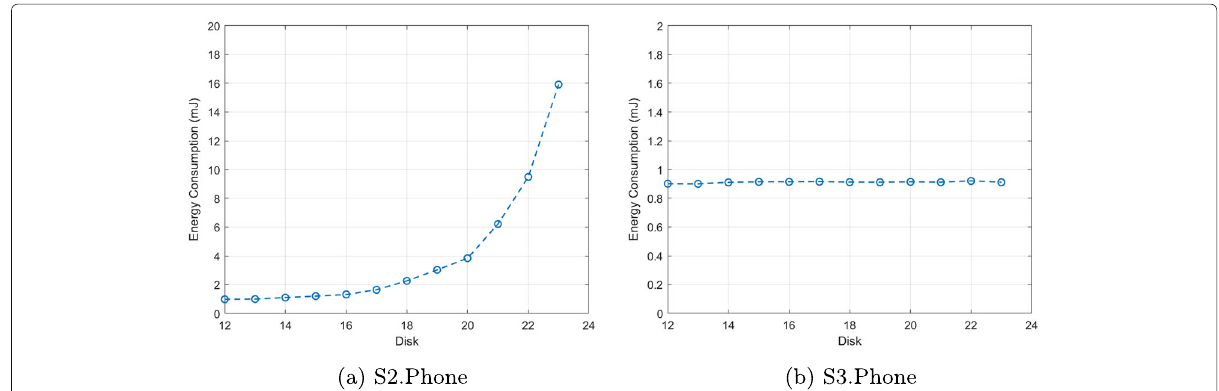
Fig. 8 Energy Consumption Measurement Results of